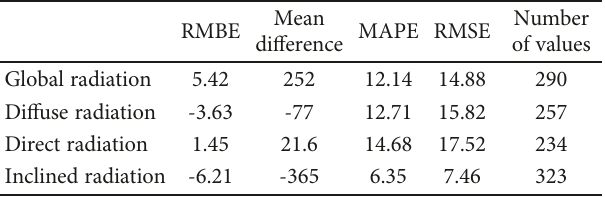
Table 6: The performance of models used to estimate daily solar irradiation for the Rabat